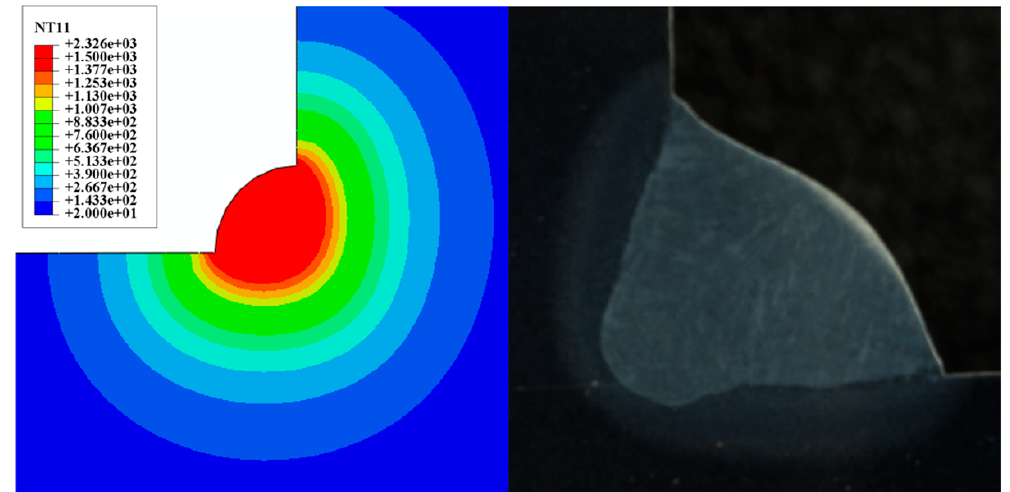
Figure 6. Comparison among calculated results and experimental results (Sample 1#).